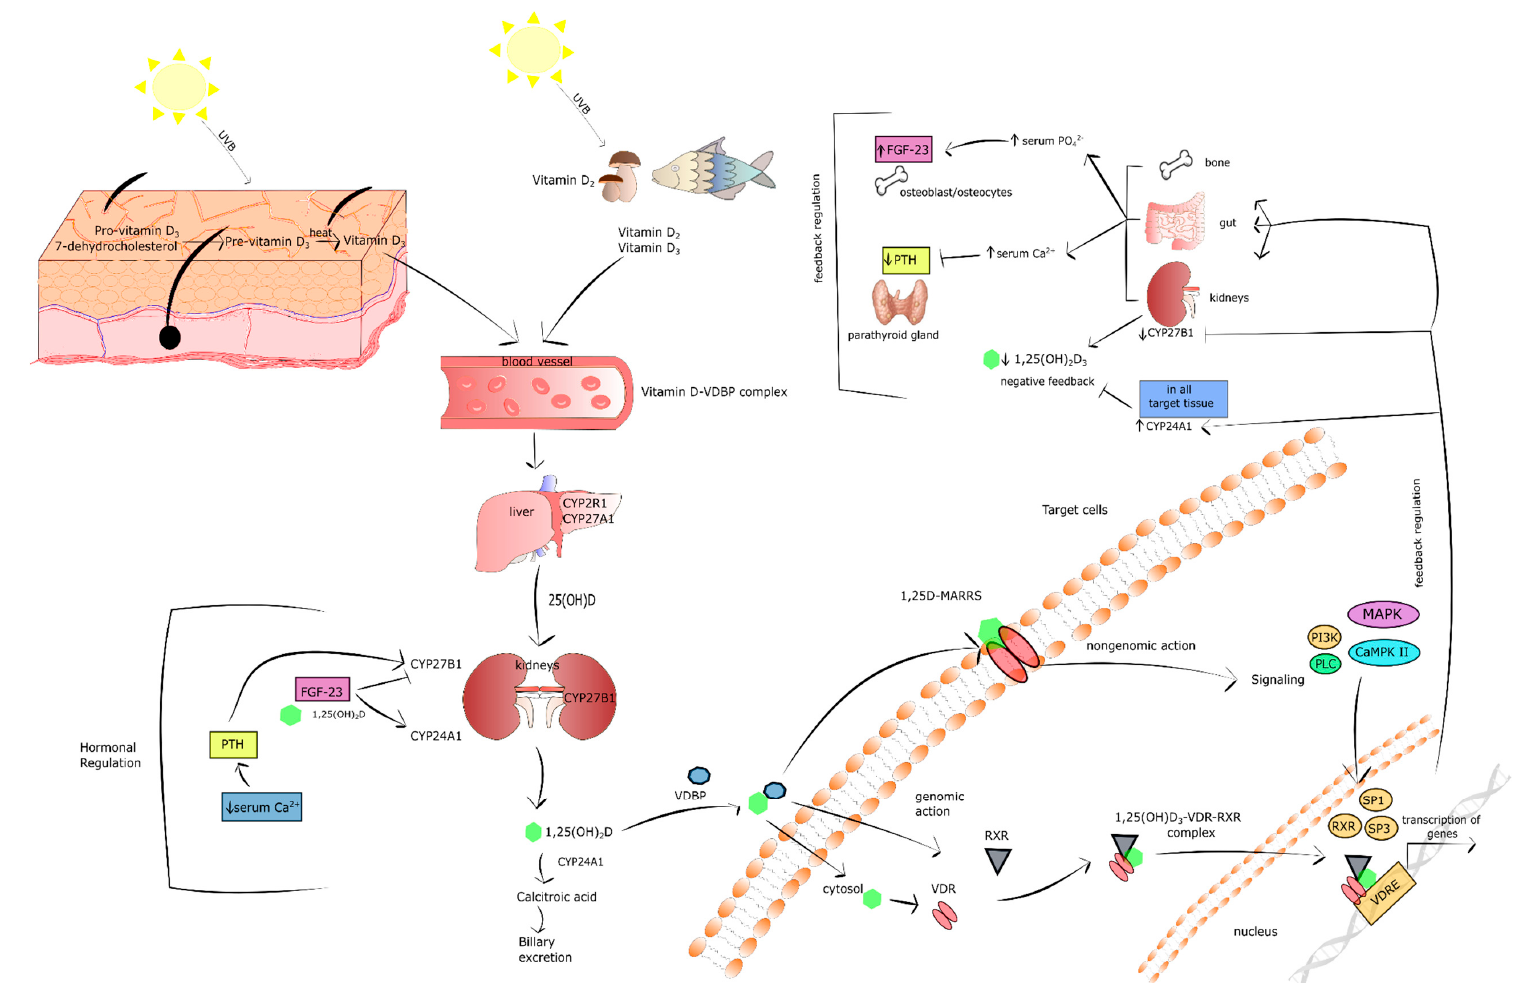
Figure 1. The overview of vitamin D . Stimulatory interactions are expressed by arrows and inhibition by T-bars. ↓ denotes decrease ↑ denotes increase.